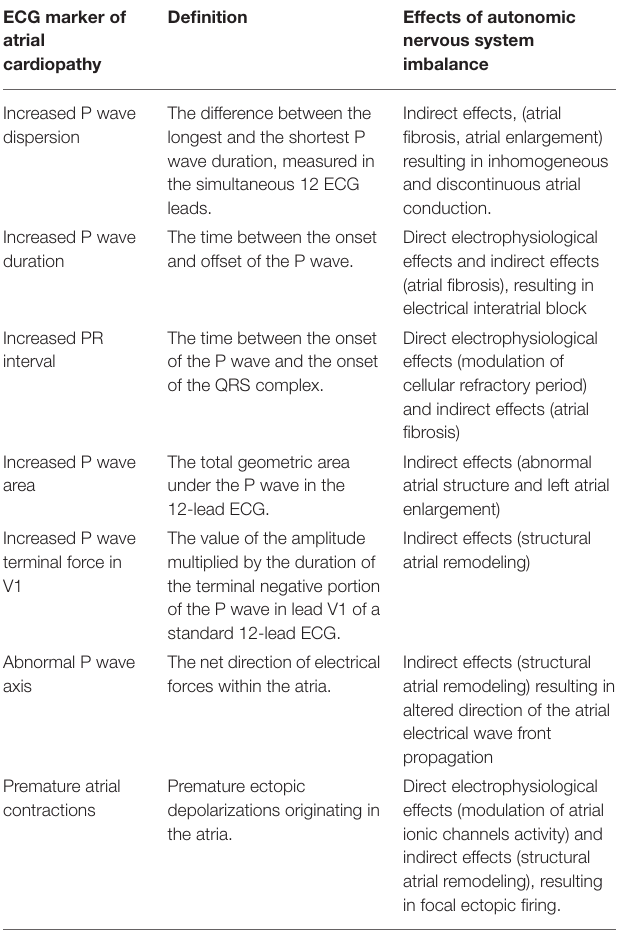
TABLE 1 | Electrocardiographic markers of atrial cardiopathy and influences of autonomic nervous system. ECG marker of